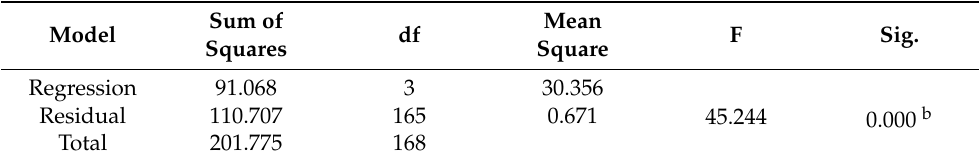
Table 13. Multilinear Regression results of female samples/Coefficients. Standardized Unstandardized Coefficients Coefficients t Sig. Model B Std. Error Beta (constant) Overweight 0.435 Family